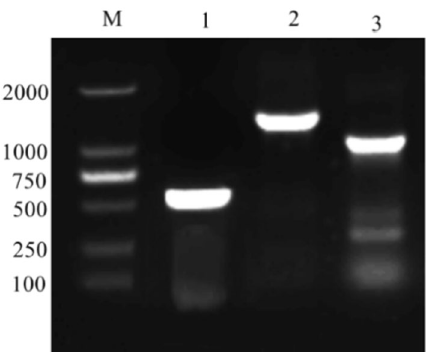
Fig. 2 Agarose gel electrophoresis of PCR products amplified from the ITS region of Xct1 isolates. Note : M: marker; 1: ITS sequence; 2: beta-tubulin sequence; 3: EF sequence